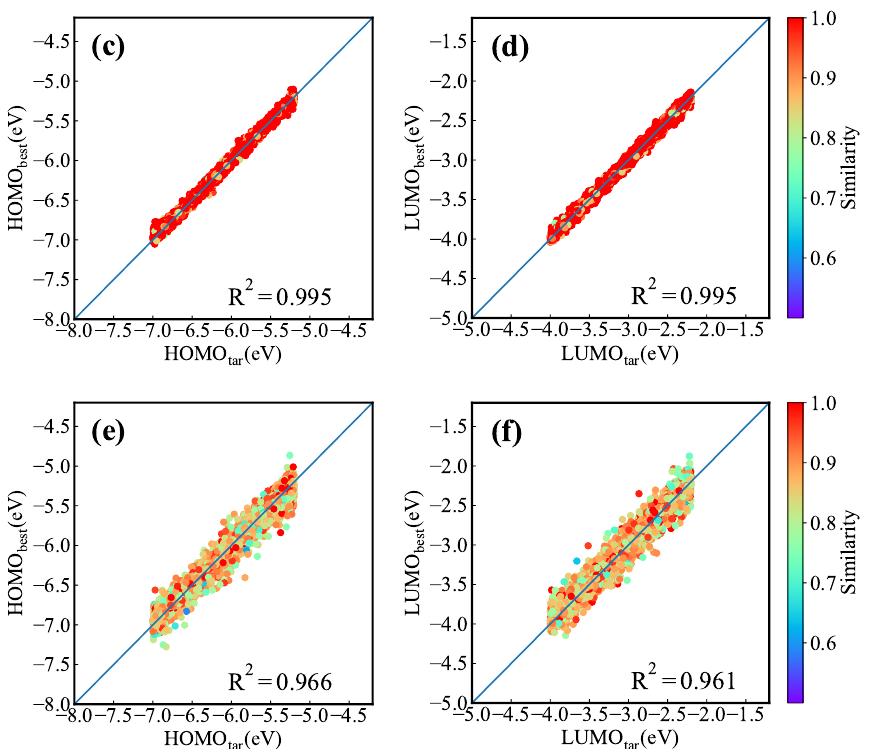
Figure 4. The performance of the molecular generation model for 4000 desired HOMO/LUMO energies. ( a ) The predicted HOMO energies versus targeted HOMO energies and ( b ) the predicted LUMO energies versus targeted LUMO energies of molecules generated in one generation process. The predicted values versus the targeted values of ( c ) HOMO and ( d ) LUMO energies of the best matched molecules screened out in 30 generation processes. The predicted values versus targeted values of ( e ) HOMO and ( f ) LUMO energies of the best matched new molecules screened out in 30